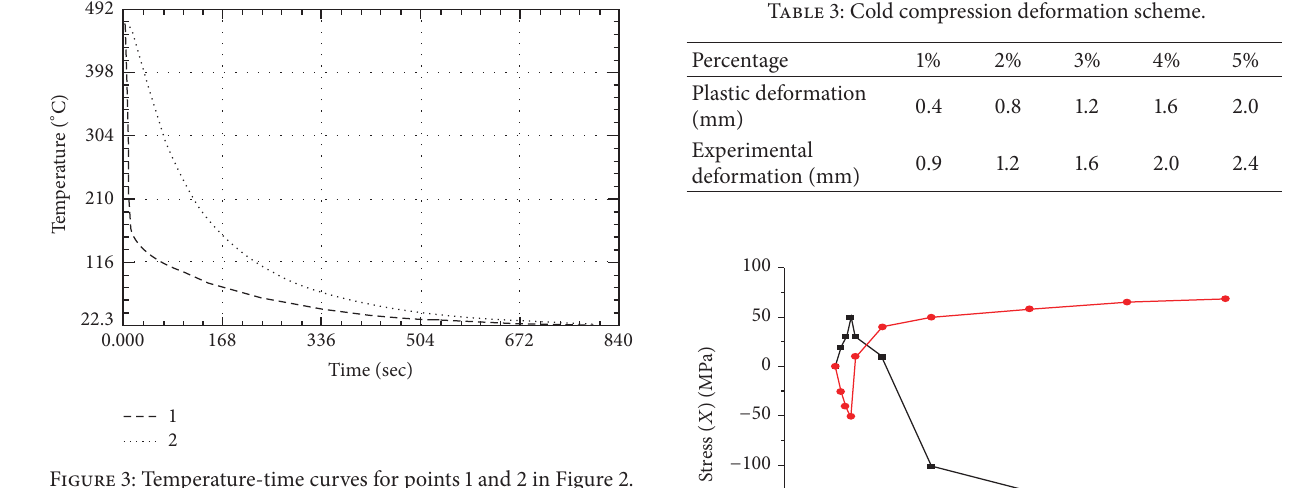
Figure 3: Temperature-time curves for points 1 and 2 in Figure 2.